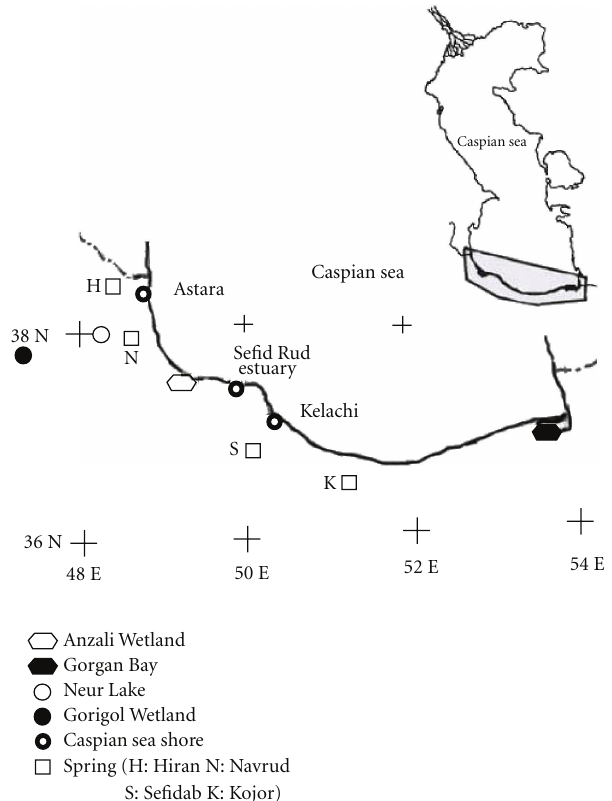
Figure 1: Sampling localities in northern parts of